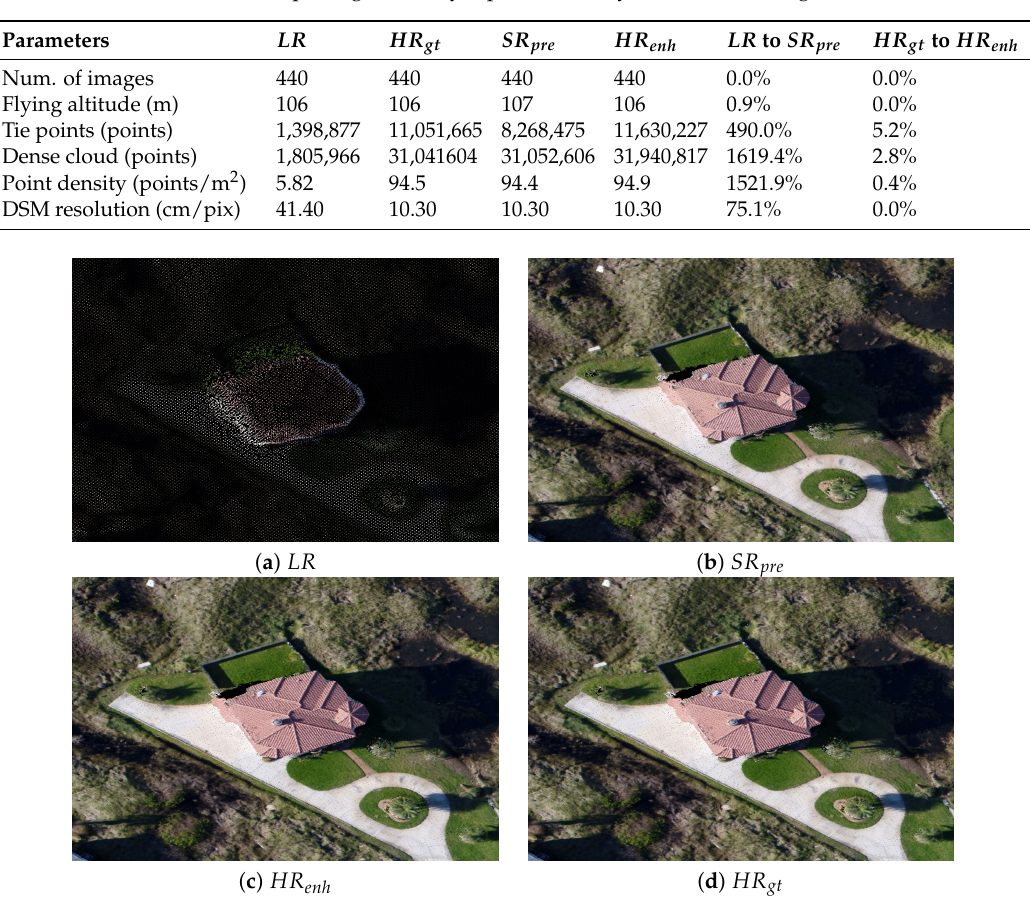
Figure 11. Camera locations and related uncertainties for image data sets. Ellipse color represents Z error. Errors in X and Y directions are represented by ellipse shape. Black dot within each individual ellipse represents estimated camera locations. Table 5. SFM photogrammetry report summary for different image sets.